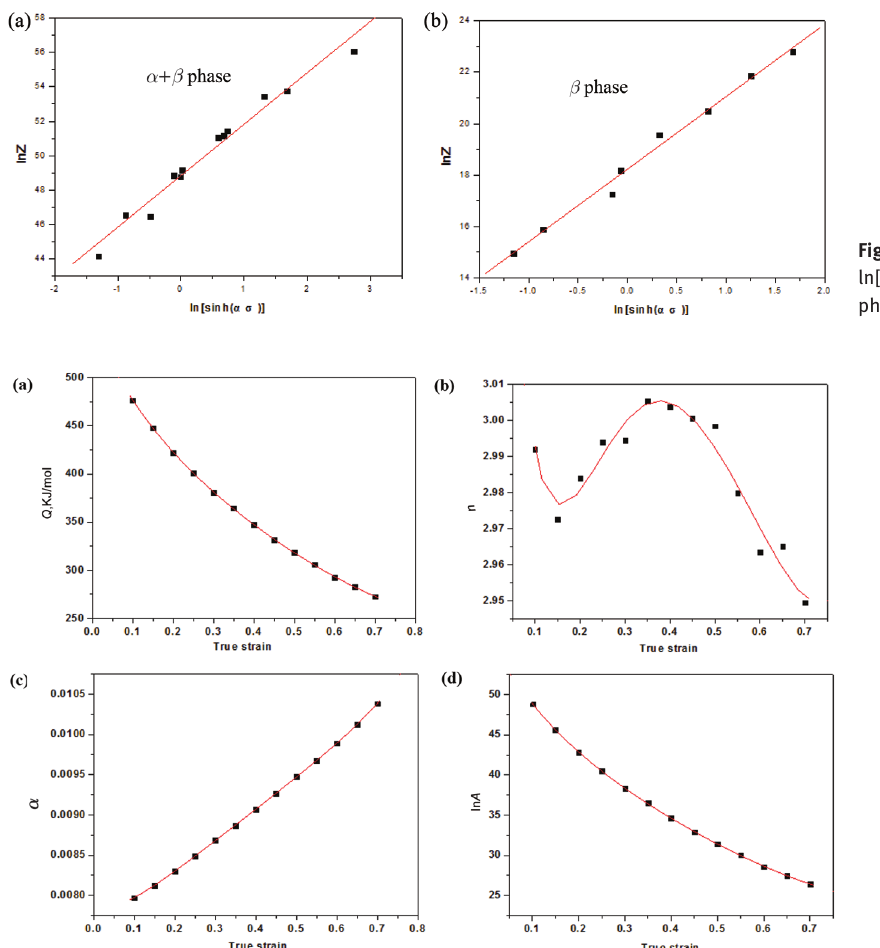
Figure 9: Polynomial fit of relation- ships: (a) Q ; (b) n ; (c) α ; (d) ln A ; with strain for α + β